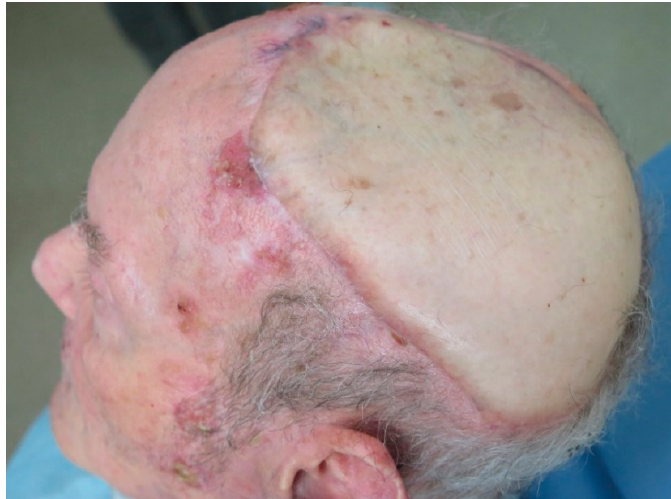
Figure 10. ALT flap. Follow-up four months after surgery with poor aesthetic